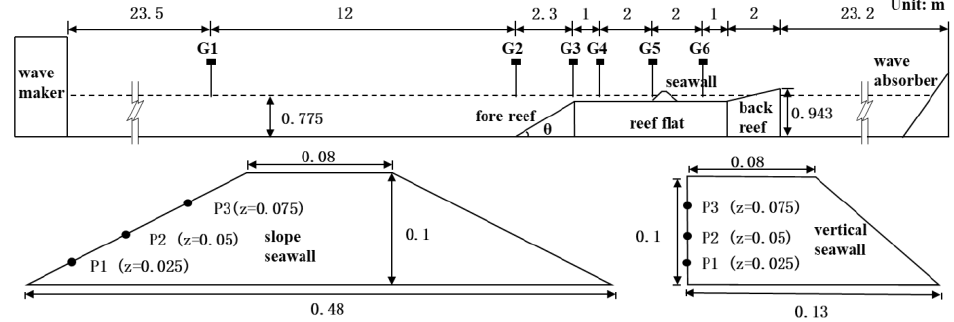
Figure 1. Schematic representation of the experimental setup and